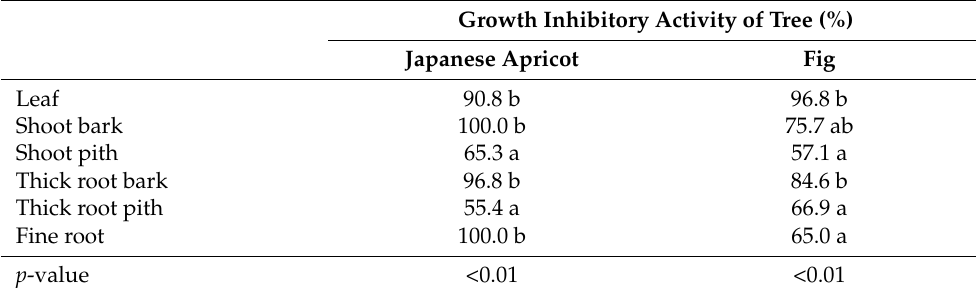
Table 2. Growth inhibitory activity of the tissue types of Japanese apricot and Fig tree. Growth Inhibitory Activity of Tree (%) Japanese Apricot Fig